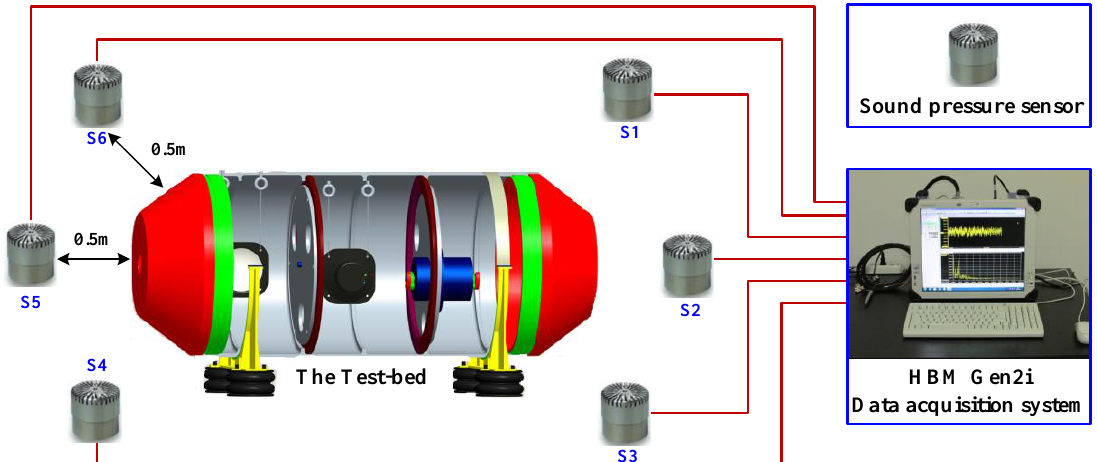
Figure 10. The measuring system of the test